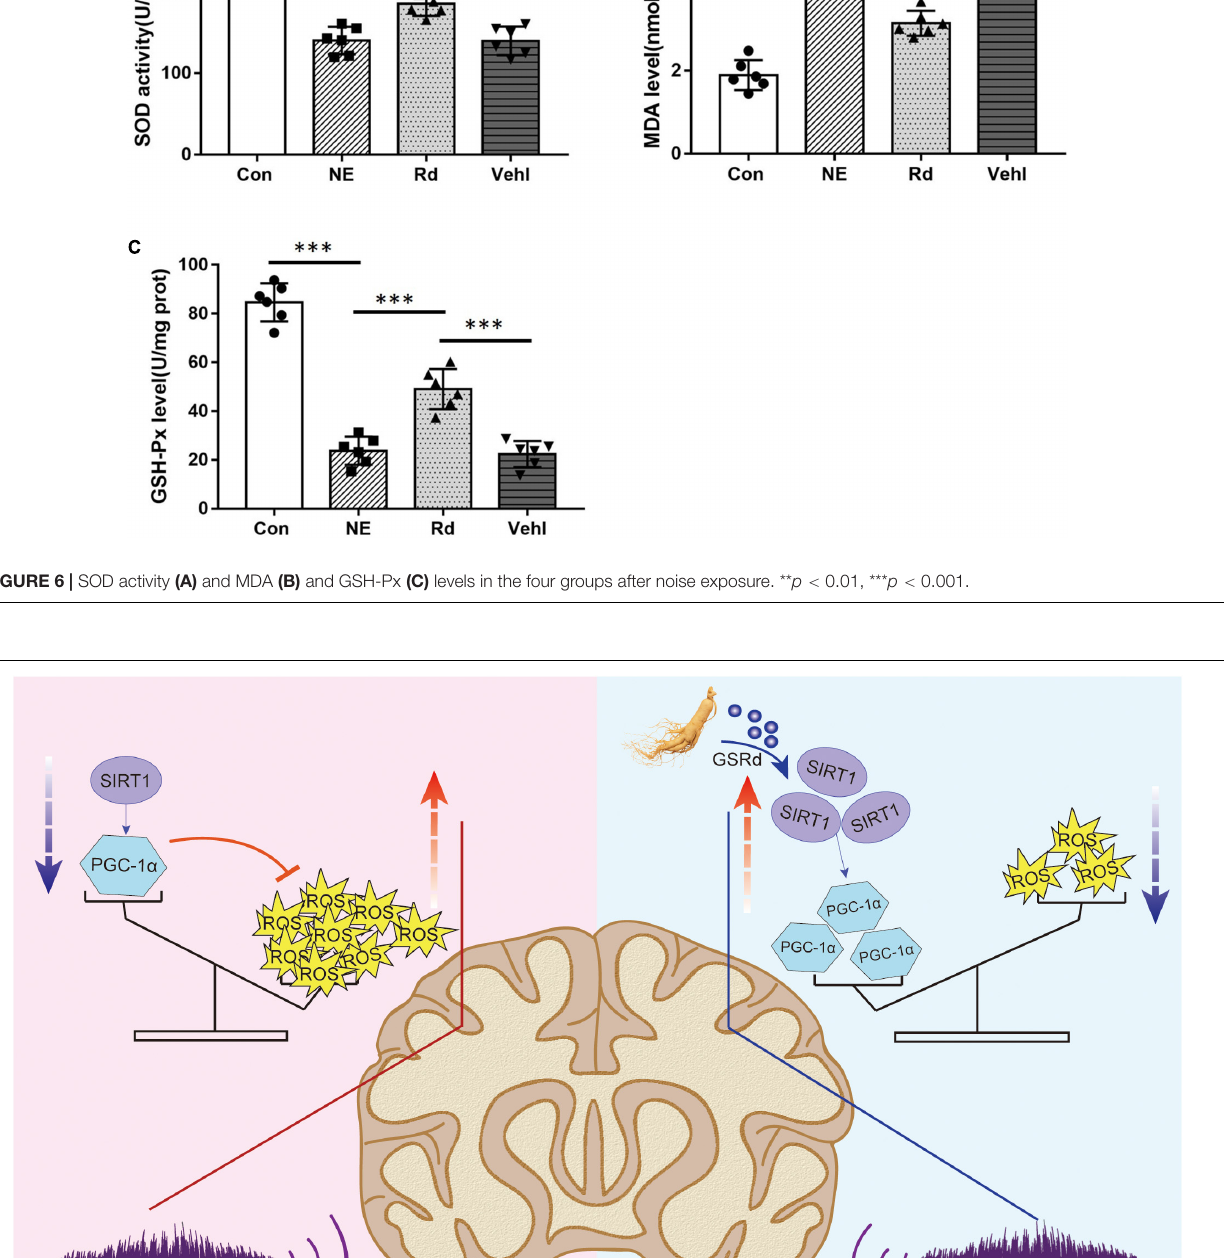
Frontiers in Physiology |